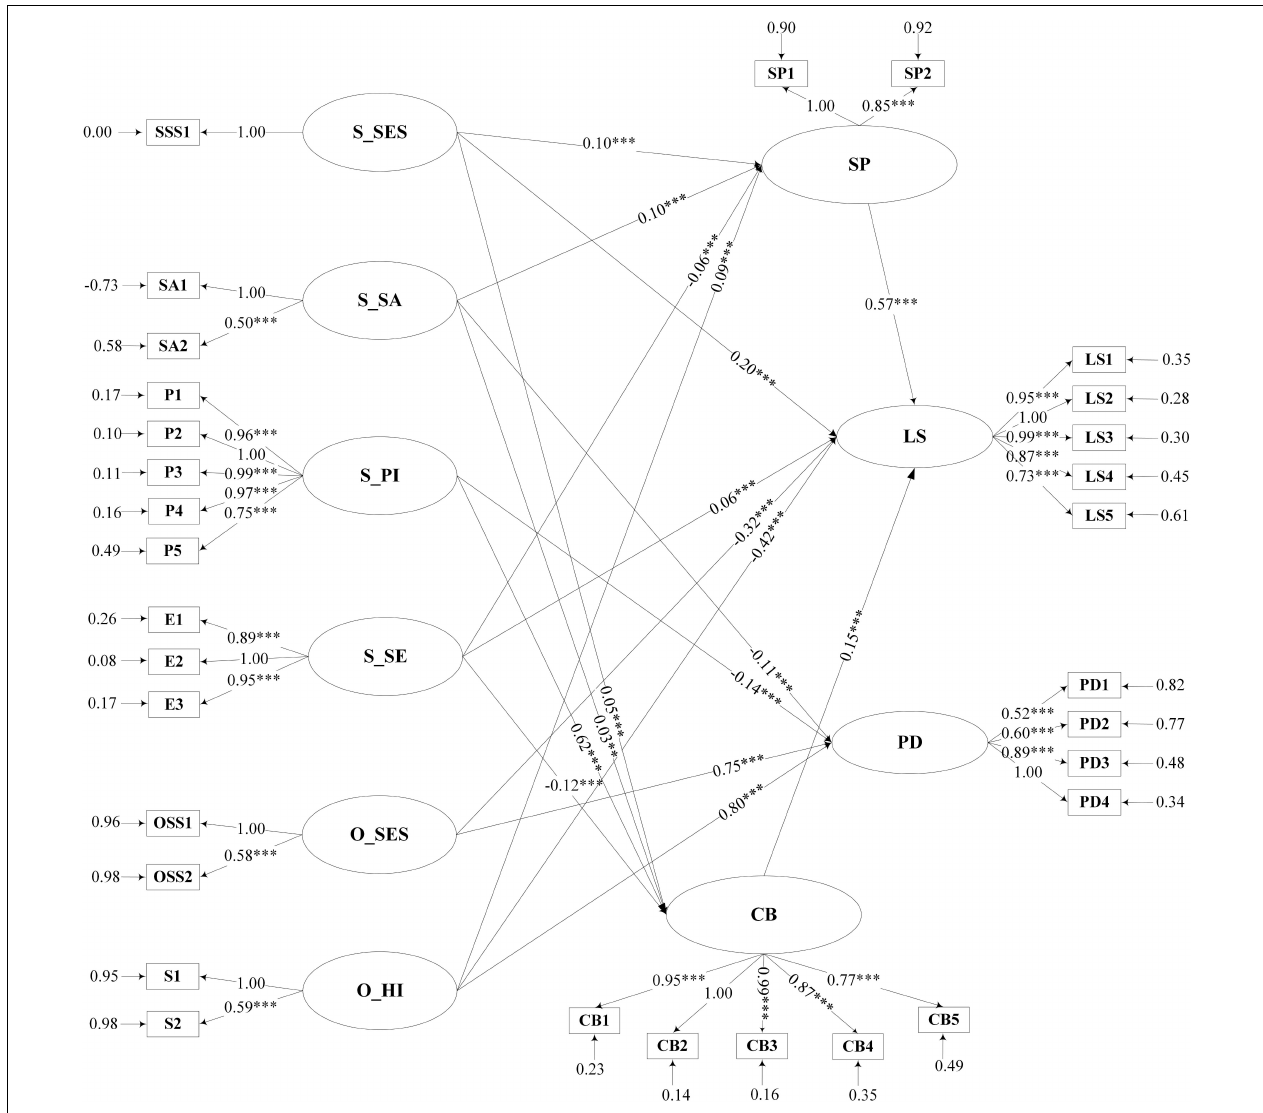
FIGURE 2 | Path Coefficients for the Effects of Subjective/Objective Status on Young Internal Migrants’ Life Satisfaction and Psychological Distress. SSES, Subjective Socioeconomic Status; SSA, Social Adaptation; SPI, Psychological Integration; SSE, Social Exclusion; OSES, Objective Socioeconomic Status; OHI, Health Insurance; SP, Social Participation; CB, City Belonging; LS, Life Satisfaction; PD, Psychological Distress. **p < 0.01, *** p < 0.001.